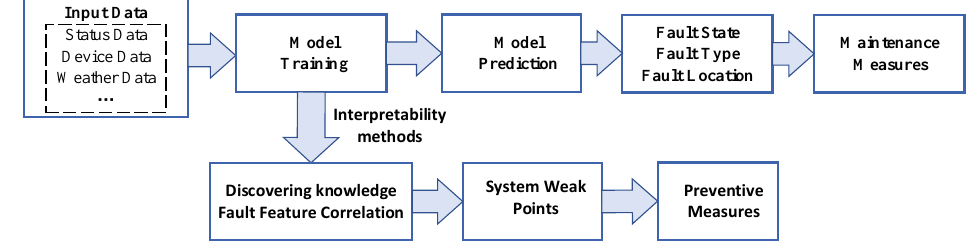
Figure 3. A flowchart of interpretable ML methods for smart grid fault